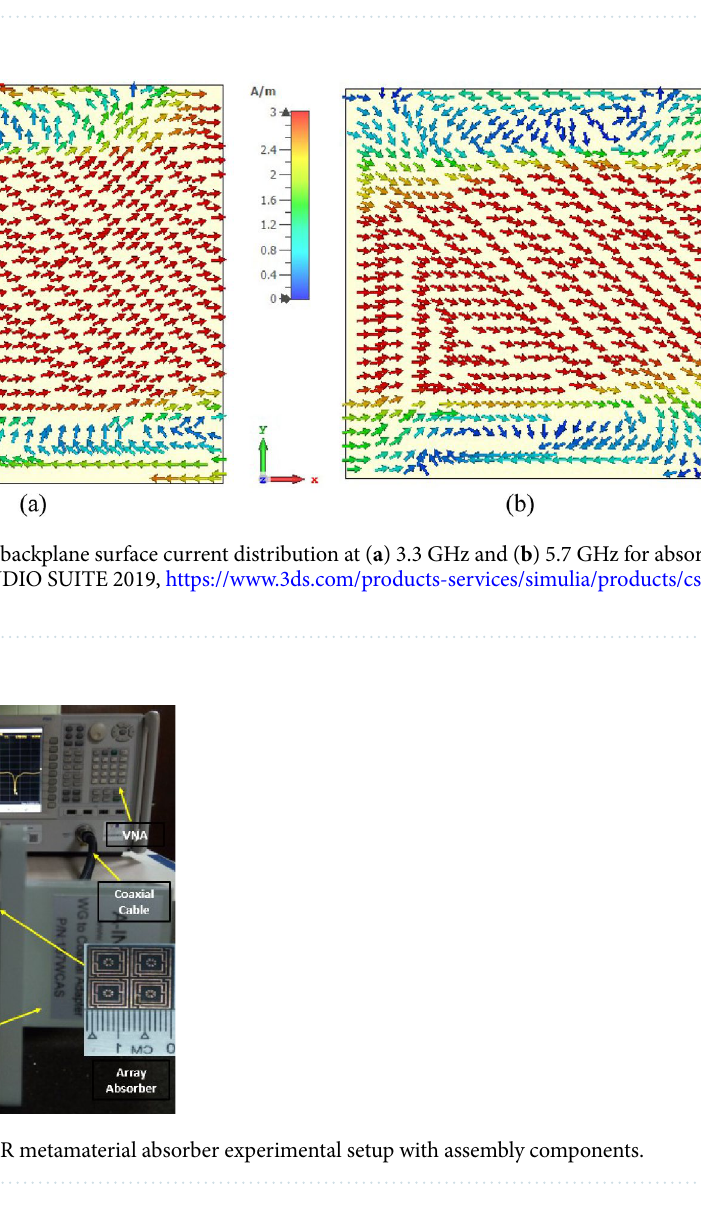
Figure 20. Surface current circulation in absorber resonator patches at ( a ) 3.3 GHz and ( b ) 5.7 GHz (CST STUDIO SUITE 2019, https:// www. 3ds. com/ produ cts- servi ces/ simul ia/ produ cts/ cst- studio- suite) 39 .